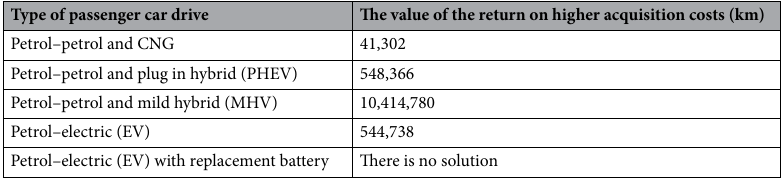
Table 2. Calculating the return on investment for the acquisition of alternatively fuelled vehicles.